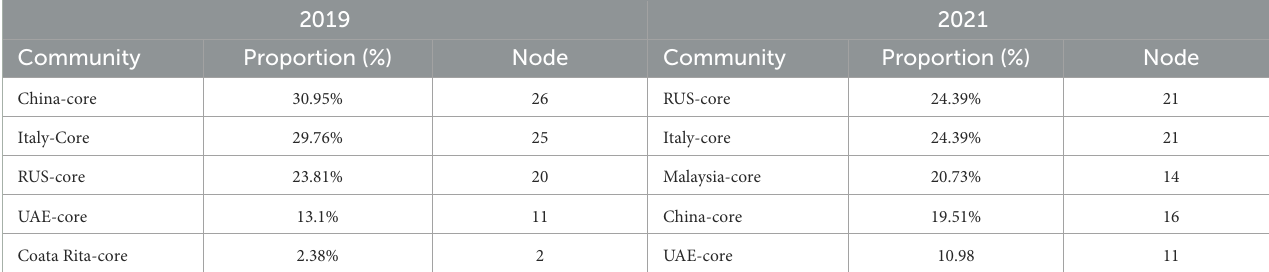
TABLE 4 Characteristics of the agricultural products trade network community